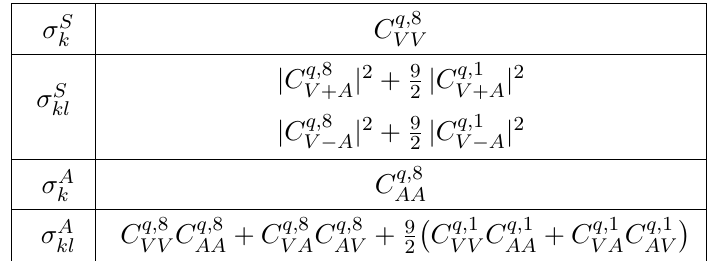
for charge-symmetric and -asymmetric kl